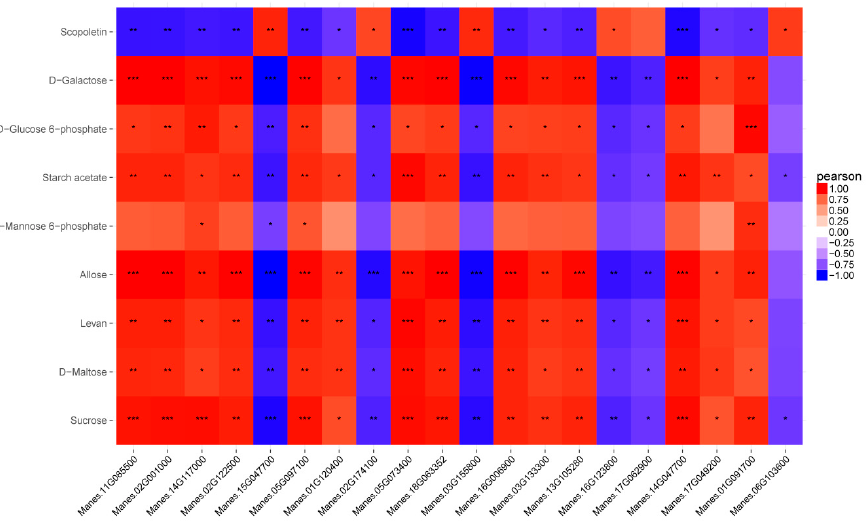
Figure 4. Correlation heatmap of SCMs and DEGs in sucrose and starch metabolism between SC and PC in cassava. Colored in “red” and “blue” indicated positive and negative correlations, respectively. SC: M. esculenta Crantz cv. sugar cassava GPMS0991L; PC: M. esculenta Crantz cv. pink cassava BRA117315. Correlation differences are indicated by asterisk (* p < 0.5, ** p < 0.01, *** p < 0.001).